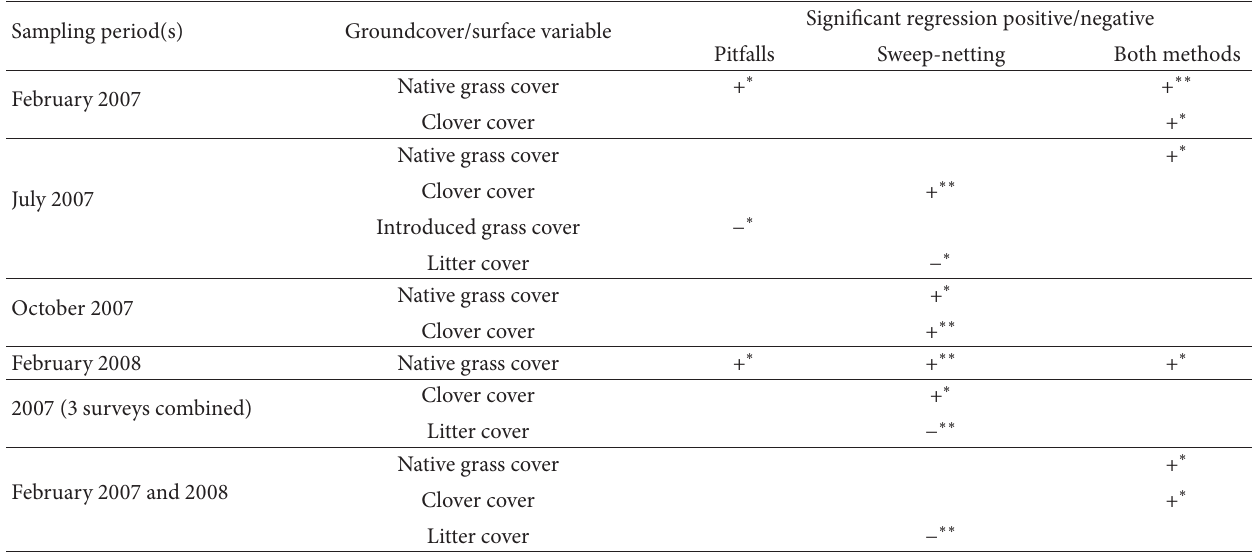
Table 5: Results of pairwise regressions of richness (dependent variable) on groundcover/surface variables. Only significant regressions ( 𝐹 test) are shown, as indicated by sign and significance